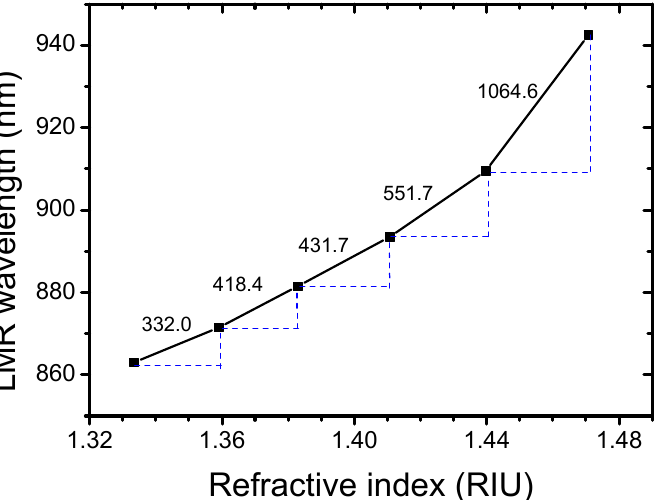
Figure 6. The LMR wavelength and the sensitivities for the TC-LMR sensor as a function of the RIs of glycerol solutions. of glycerol